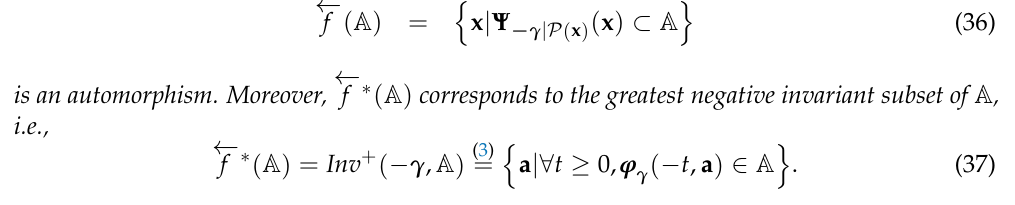
Figure 7. An impossible situation where a / ∈ Inv + ( A ) but a ∈ Theorem